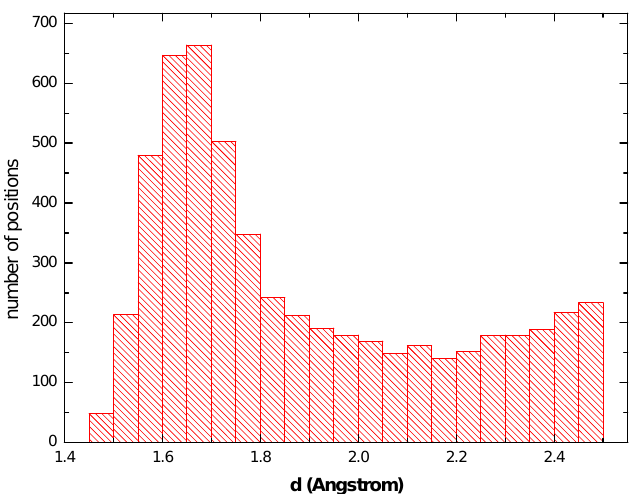
The H atom in a tetrahedral site has four neighboring atoms of Fe(Al) located at the √ distance d tet = 5/4 a while the octahedral site has six atoms in the close distance when √ 4 four of them are located at the distance d oct = a / 2, and two at d oct = a /2. Considering the 2 4 minimum-energy lattice parameter for the supercell with the hydrogen concentration of 0.23% (17.04 Å) divided by six (in order to obtain the lattice parameter a as in Figure 2), we get the following values of the distances between the H interstitial and the neighboring atoms: d tet = 1.59 Å, d oct = 2.01 Å and d oct = 1.42 Å. The interatomic distances obtained 2 4 4 during the 1000 FP-MD steps at the constant temperature of 300 K for the hydrogen concen- tration of 0.23% are shown in Figure 3. The most frequently occurring distances between the hydrogen and the neighboring atoms are within the interval d ∈ (cid:104) 1.6; 1.7 (cid:105) Åwhich matches very well the expected value for the tetrahedral site ( d tet = 1.59 Å). Figure 3 does 4 not contain any other maxima and there is no evidence of the distance close to 1.42 Å which would indicate H in the octahedral sites. On the basis of these results we assume that the H atoms prefer the tetrahedral sites.